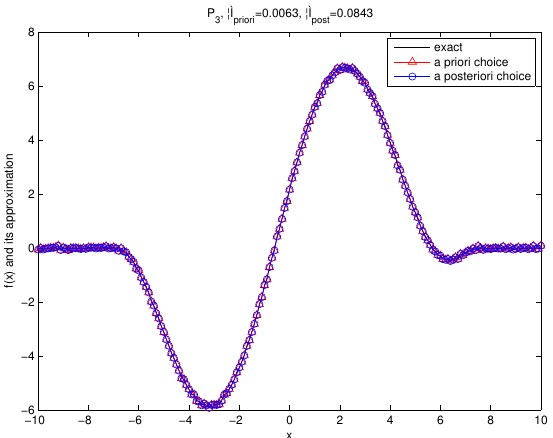
Figure 7. The exact solution and the regularized solutions of Example 2 for α = 0.5 under the a priori parameter choice and the a posteriori parameter choice. Figure 7: The exact solution and the regularized solutions of Example 2 for α = 0 . 5 under the a-priori parameter choice and the a-posteriori parameter choice.